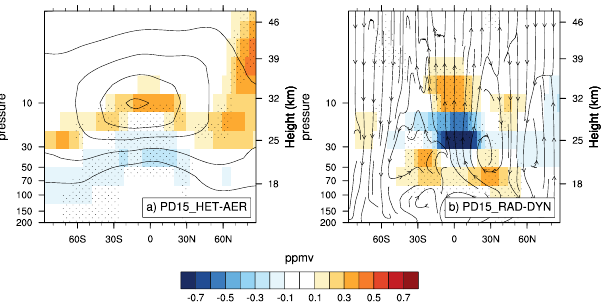
Figure 4. Ensemble mean zonal mean ozone mixing ratio anoma- lies (ppmv) for the first post eruption DJF season in the present-day ensemble experiment considering (a) the effect of aerosol heteroge- neous chemical reactions (b) the radiative-dynamic effect with the 15Tg aerosol forcing under present-day conditions. Contour lines in (a) denote the climatological average DJF ozone mixing ratios in the present-day control ensemble. The streamlines in (b) show the residual circulation anomalies (Andrews et al., 1987). Stippling indicates significant anomalies (Student’s t test p ≤ 0 .